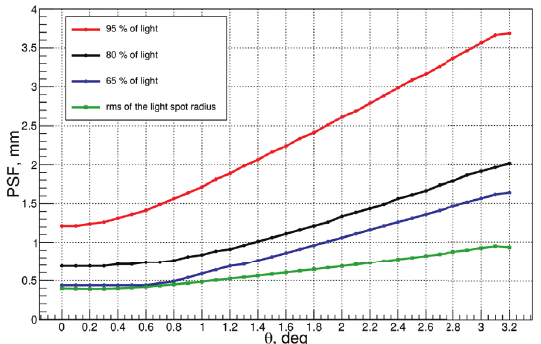
Figure 9: RMS of the radius of the light spot before (lower curve) and after (3 upper curves for di ff erent percentage of pho- ton containment) it is processed by the optical elements of the telescope from Geant 4 simulation. For brevity we call this PSF on the y-axis.